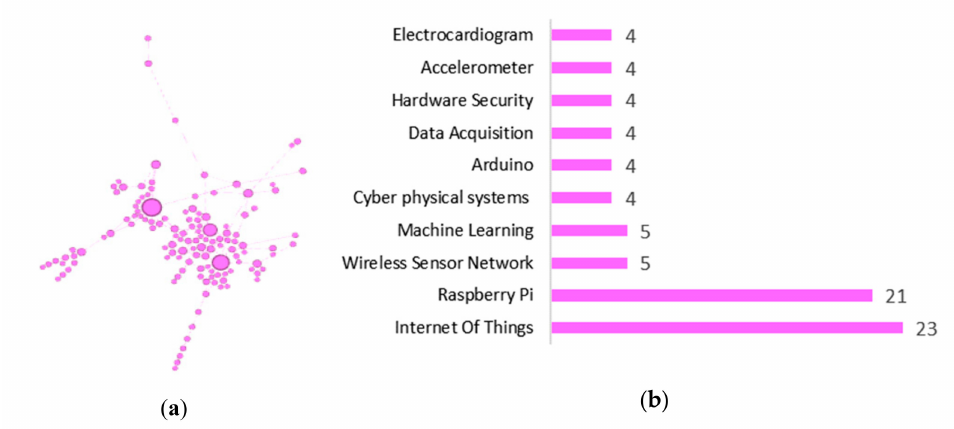
Figure 12. Representation of the Embedded Computer System community: ( a ) Isolated distribution of publications. ( b ) Keywords of the